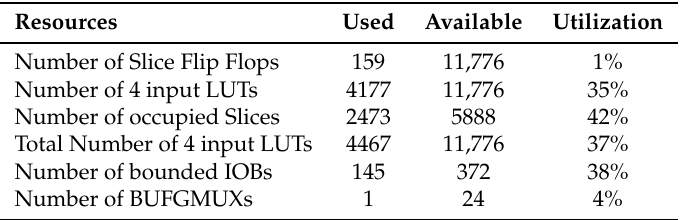
Table 1. FPGA utilization summary for the master 4–scrolls UDS.